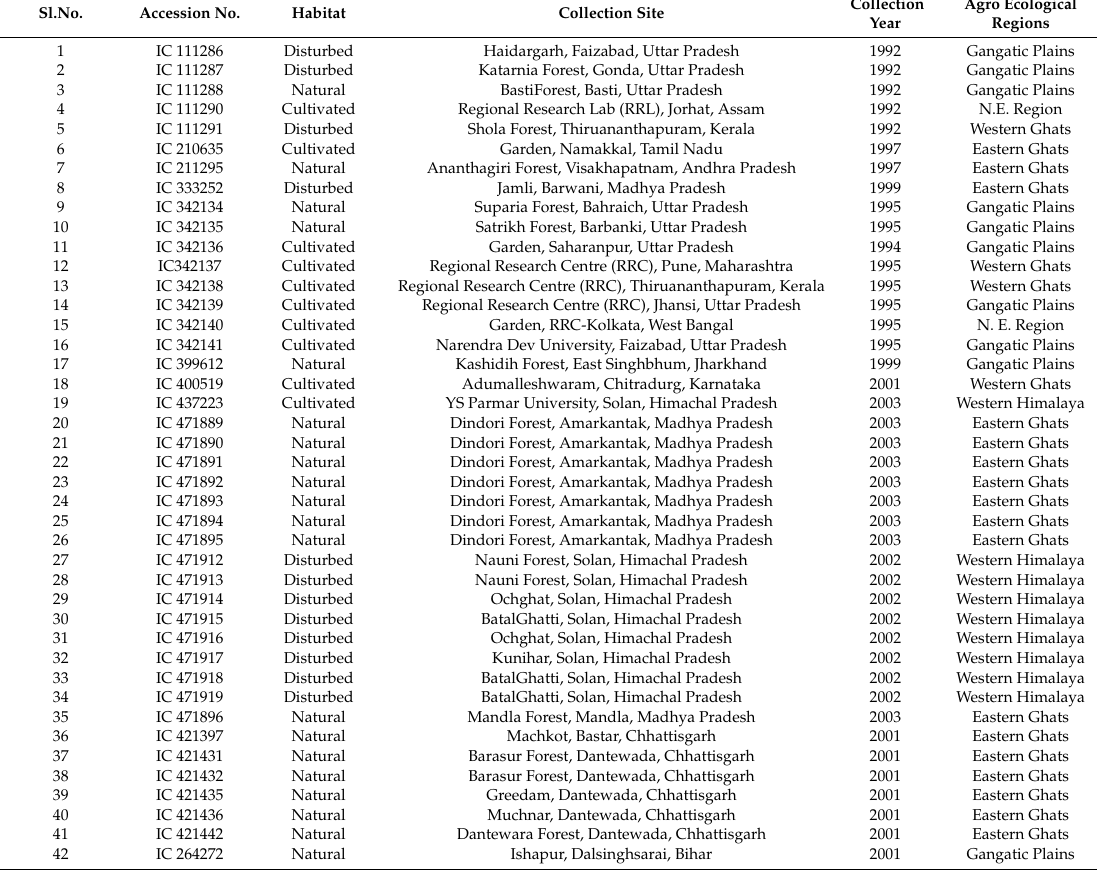
Figure 1. Andrographis paniculata accessions collected from different geographical regions of India. Table 1. The details of Andrographis paniculata accessions studied.